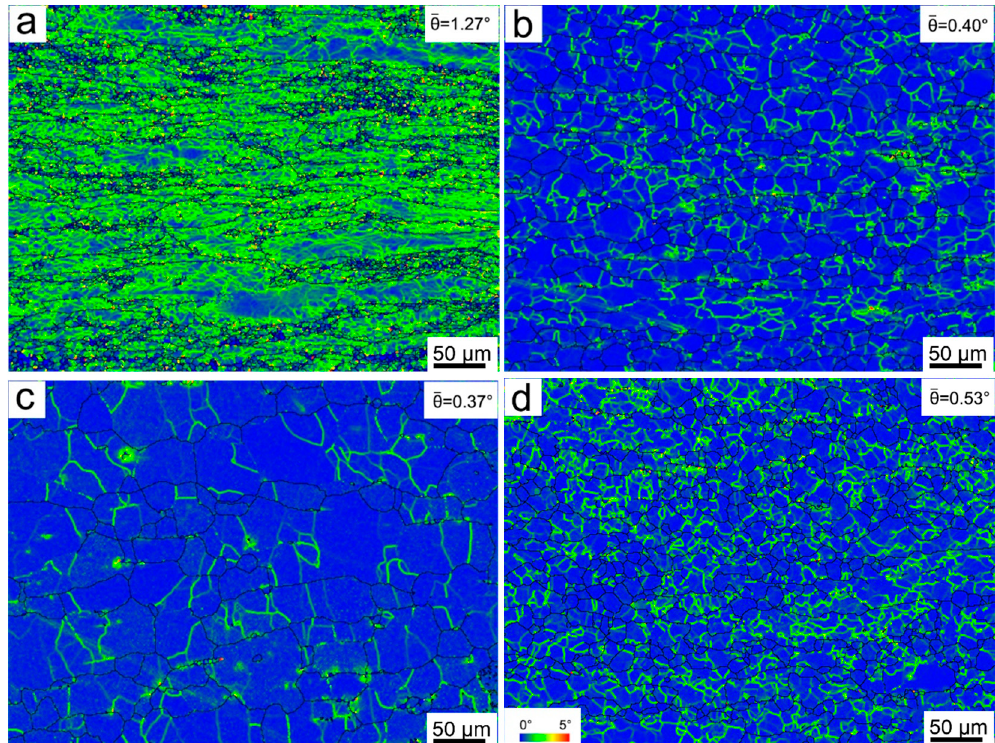
Figure 11. Kernel average misorientation (KAM) maps for the 0Cr18AlSi steel tested under different deformation conditions: ( a ) 1.7 × 10 − 4 s − 1 and 873 K; ( b ) 1.7 × 10 − 4 s − 1 and 1023 K; ( c ) 1.7 × 10 − 4 s − 1 and 1123 K; ( d ) 1.7 × 10 − 2 s − 1 and 1123 K.